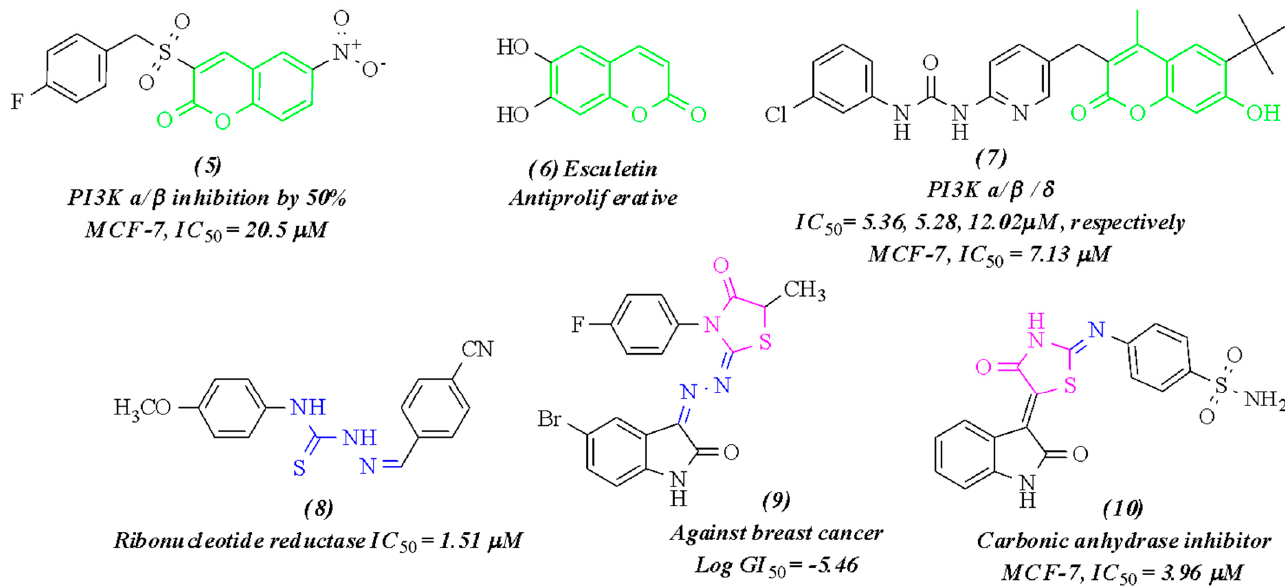
Figure 2. Reported coumarin and thiazolidine containing anticancer agents. Structures 5 to 10 are adapted, respectively, from [20,24,27,28,31,32].